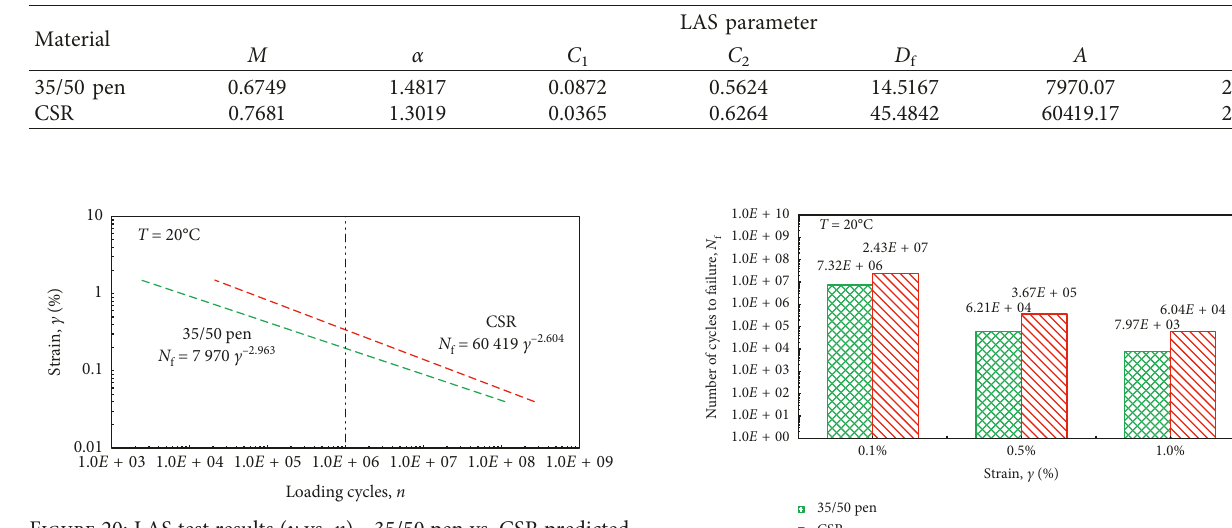
Table 4: Linear amplitude sweep parameters.